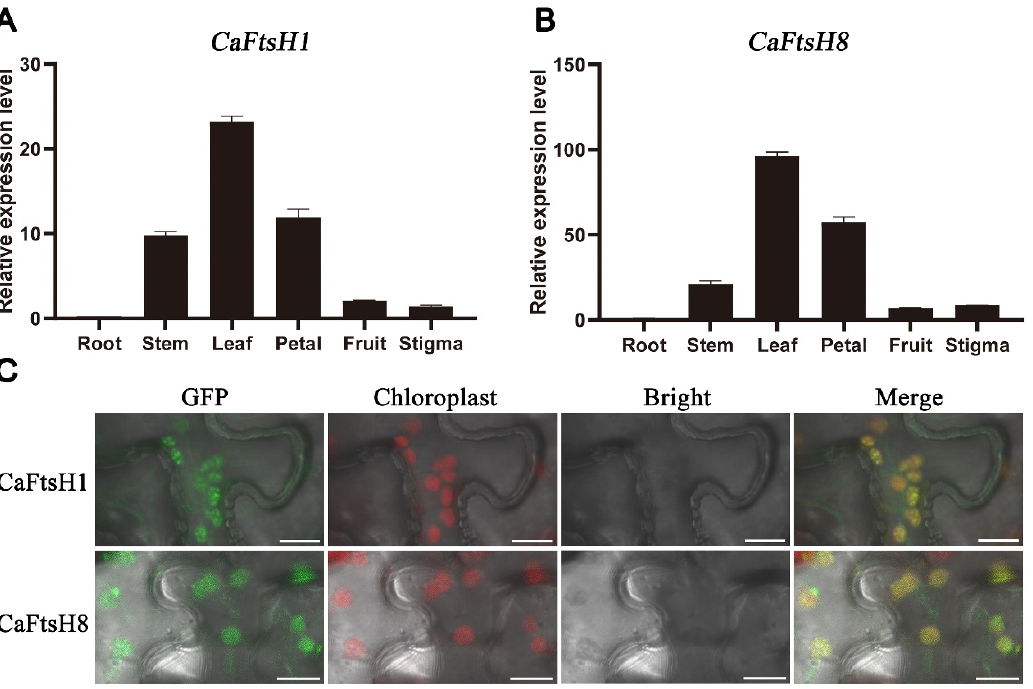
Figure 4. Expression patterns and subcellular localization of CaFtsH1 and CaFtsH8. ( A , B ) Expression patterns of CaFtsH1 and CaFtsH8 in the roots, leaves, petals, stems, fruits, and stigmas of the C. annuum cultivar Z101, as determined based on RT-qPCR utilizing the expression of CaUBI-3 as a reference. Values are expressed as average ± SD ( n = 3). ( C ) Subcellular localization of CaFtsH1 and CaFtsH8 in N. benthamiana leaves. Merged pictures contain the green fluorescence of CaFtsH1 or CaFtsH8 (first panels), chloroplast red fluorescence (second panels), and the bright-field image (third panels). Bars = 12 μ m.